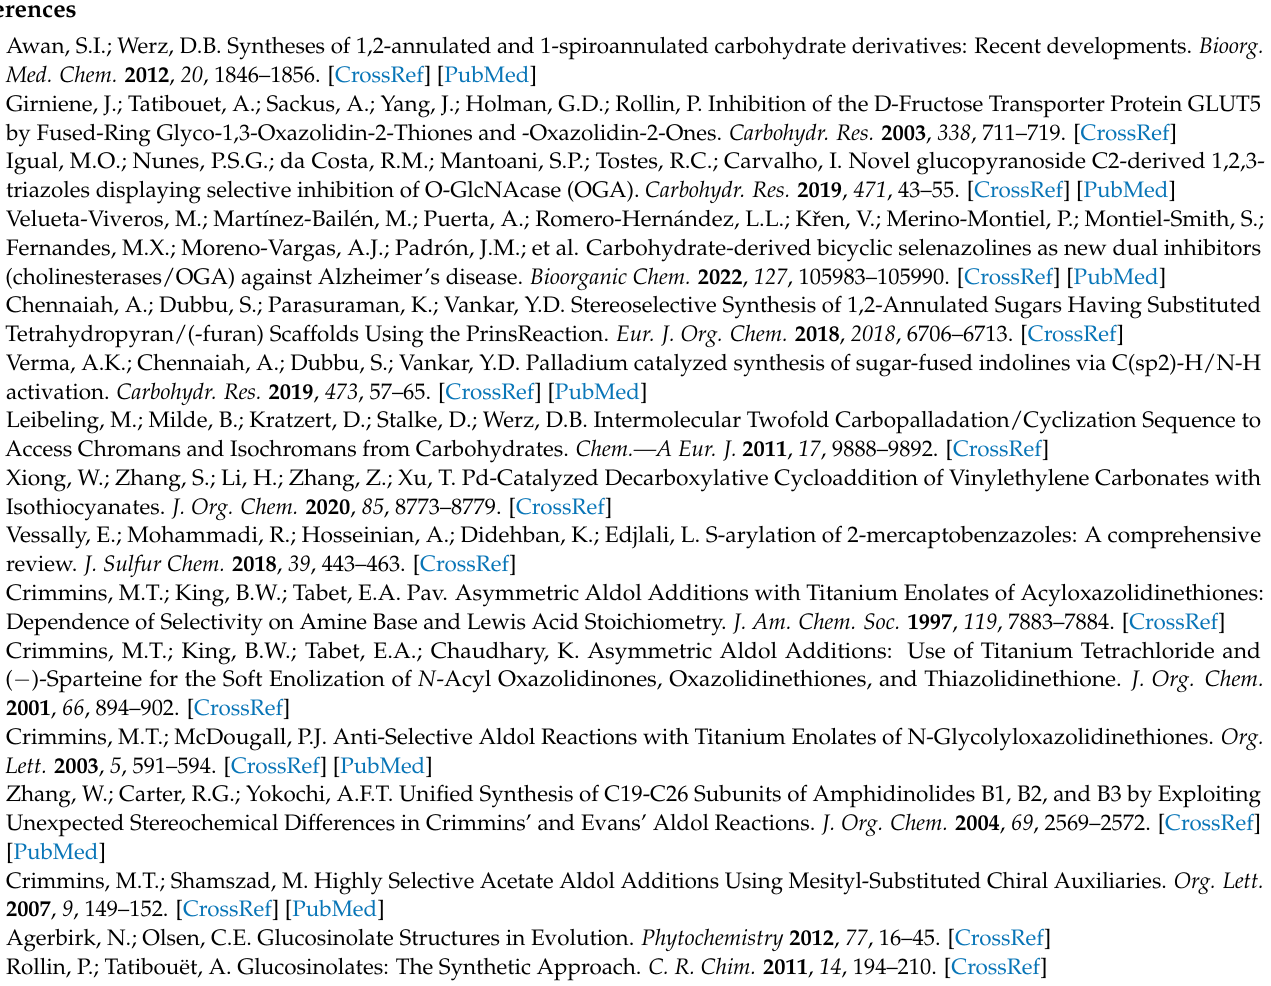
compound 21, Figure S34: 13 C NMR (100 MHz, CDCl 3 ) spectrum of compound 21, Figure S35: HRMS (ESI) of compound 21, Figure S36: 1 H NMR (400 MHz, CDCl 3 ) spectrum of compound 22, Figure S37: 13 C NMR (100 MHz, CDCl 3 ) spectrum of compound 22, Figure S38: HRMS (ESI) of compound